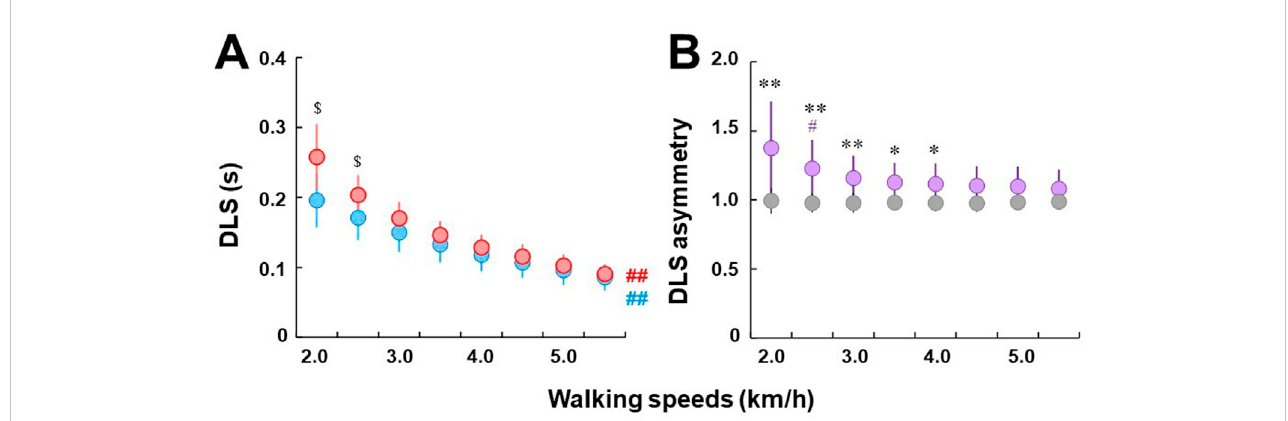
FIGURE 3 (A) Comparisonsofdoublelimbstanceacrossarangeofspeeds.Blueandredcirclesindicateinitialandterminaldoublelimbstance,respectively.Circles and error bars indicate the mean value and the standard deviation in each DLS, respectively. $ represents a signi fi cant difference between initial and terminal double limb stance at p < .05. Bold ## indicates signi fi cant differences from adjacent speeds at all tested speeds at p < .01. (B) Comparisons of double limb stance asymmetry between individuals with uTFA (purple circles) and control group (gray circles). Circles and error bars indicate the mean value and the standard deviation in each group, respectively. # represents a signi fi cant difference between the current and previous speeds at p < .05. * and ** represent signi fi cant differences in asymmetry ratio between the individuals with UTFA and control groups at p < .05 and .01,